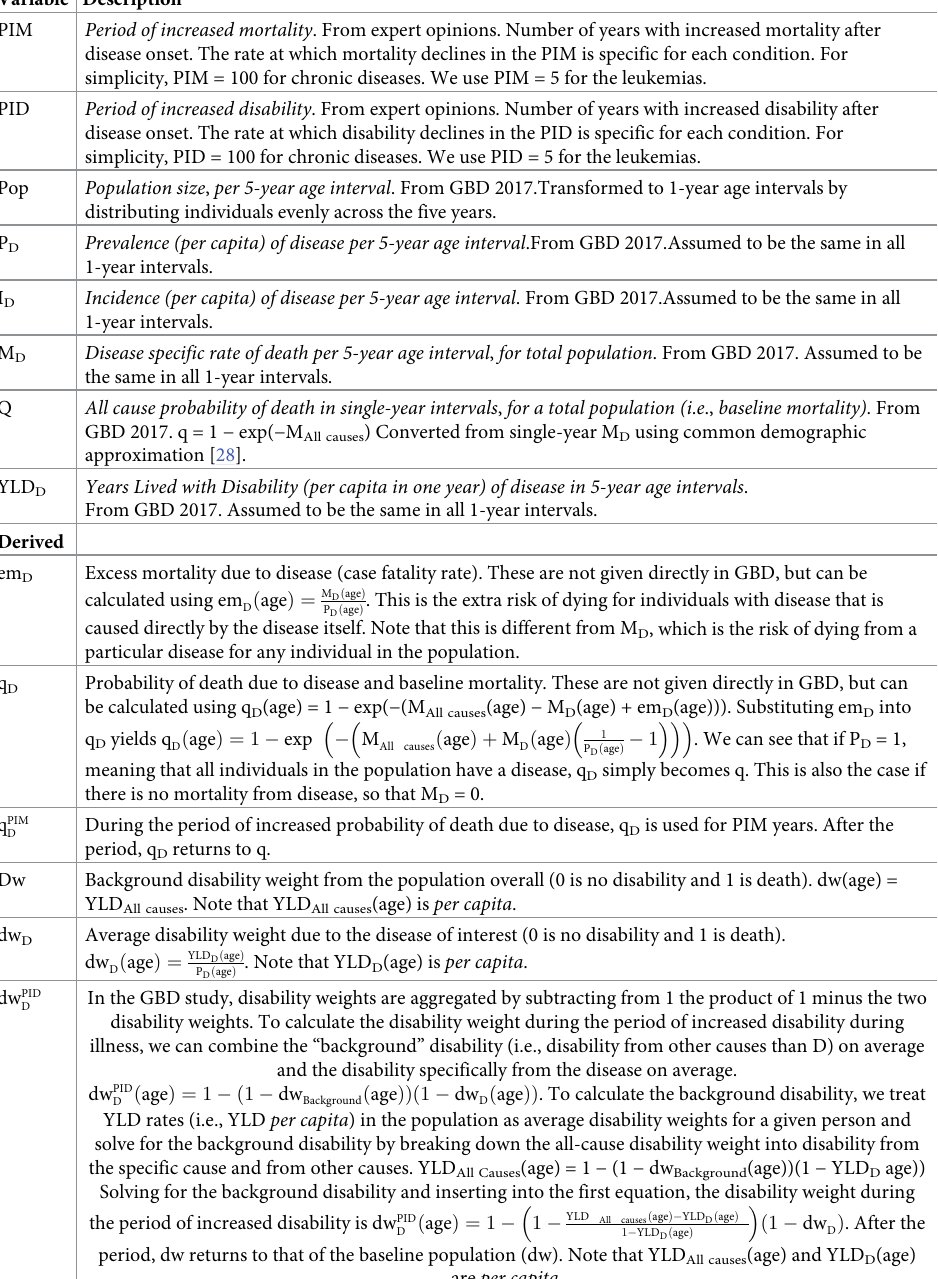
Table 1. Description of data and variables used to calculate Health Adjusted Age at Death (HAAD), the GBD 2017 study [20] is source for all calculations. Variable